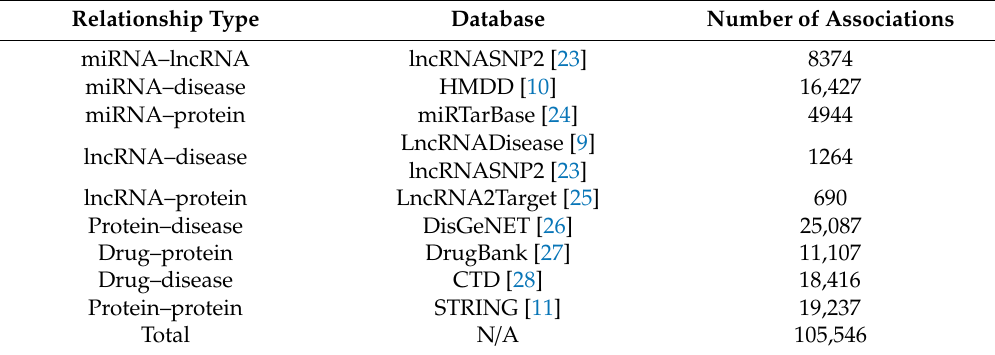
Table 1. The details of nine kinds of associations in the molecular association network (MAN).